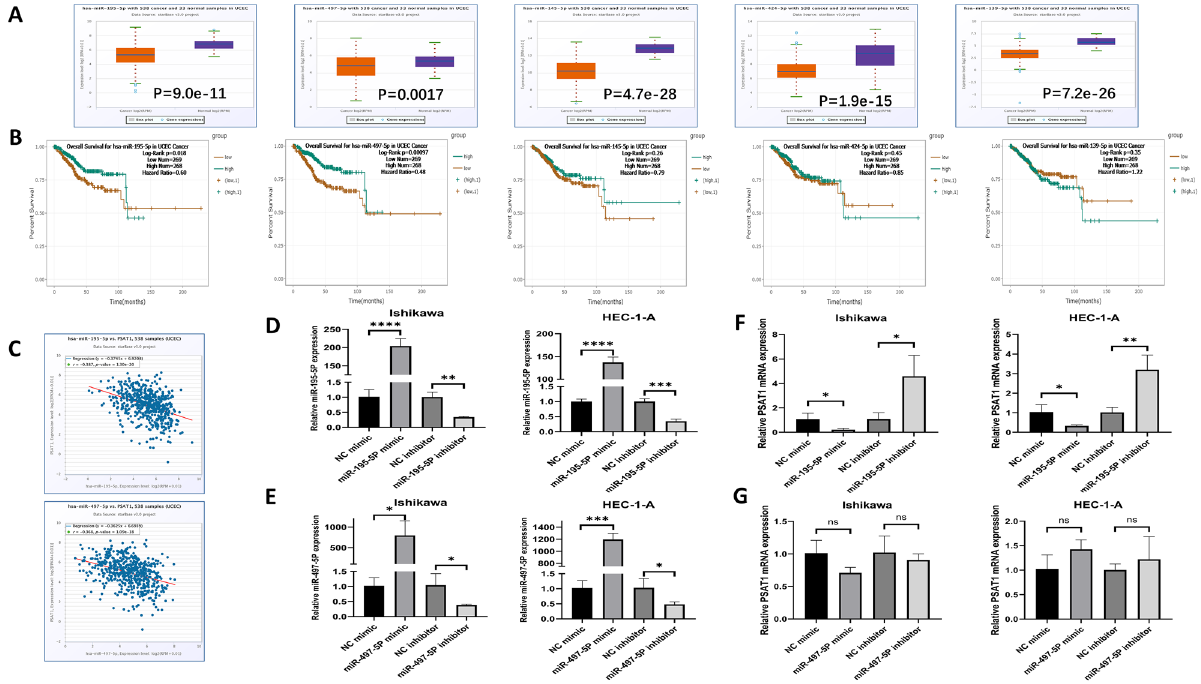
Figure 6. Prediction and analysis of miRNAs upstream of PSAT1. ( A ) The expression level of has-miR-195-5P, hsa-miR-497-5P, hsa-miR-145-5P, hsa-miR-424-5P and hsa-miR-139-5P in UCEC. ( B ) Survival analysis of hsa- miR-195-5P, hsa-miR-497-5P, hsa-miR-145-5P, hsa-miR-424-5P and hsa-miR-139-5P in UCEC. ( C ) Correlation analysis between hsa-miR-195-5P, hsa-miR-497-5P and PSAT1. ( D ) The transfection efficiency of miR-195-5P mimic/inhibitor in Ishikawa and HEC-1-A cells. ( E ) The transfection efficiency of miR-497-5P mimic/inhibitor in Ishikawa and HEC-1-A cells. ( F ) The relative mRNA expression level of PSAT1 after Ishikawa and HEC-1-A cells were transfected with miR-195-5P mimic/inhibitor. ( G ) The relative mRNA expression level of PSAT1 after Ishikawa and HEC-1-A cells were transfected with miR-497-5P mimic/inhibitor. *p < 0.05, **P < 0.01, ***p < 0.001, ****P < 0.0001, ns, P >